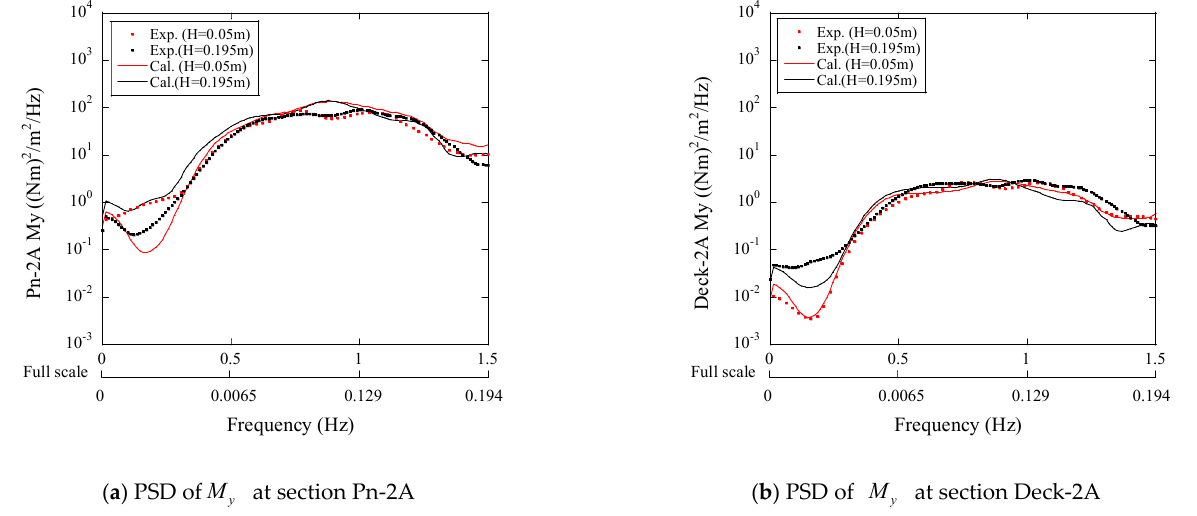
Figure 11. Normalized moments of the pontoon at section Pn-2A and Deck-2A. The sectional load at the specified sections can be evaluated by the multibody model. It is possible to increase the number of bodies to calculate the sectional load at any section. However, the increase of bodies may lead to the convergent problem of the nu- merical model. To estimate the distribution of sectional loads on a beam, the bending moment M on the beam is assumed as a function of z and is expressed as